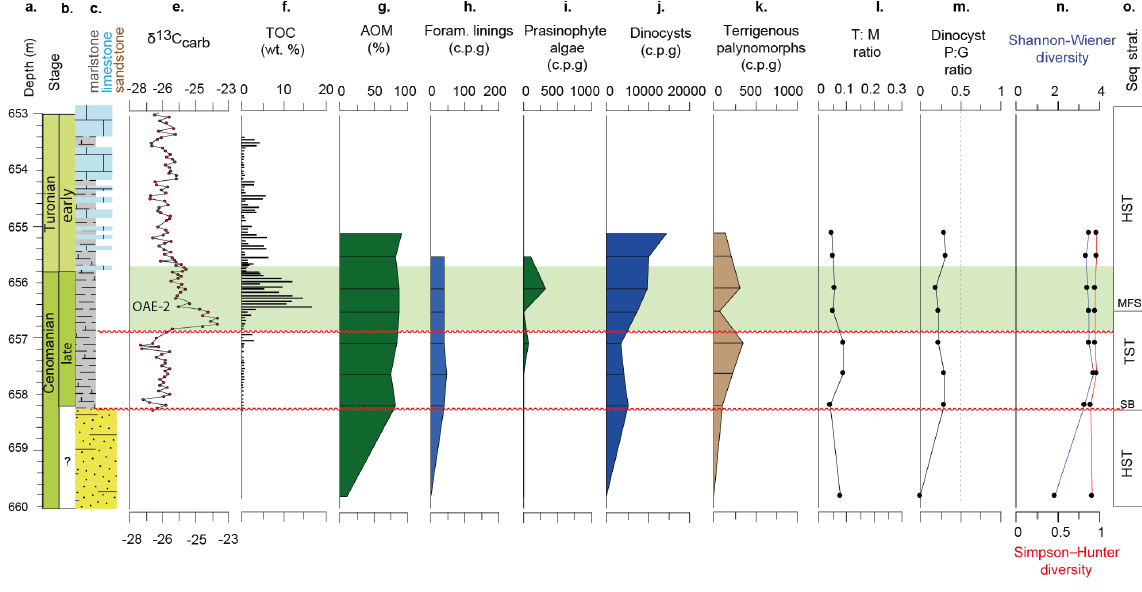
Figure 11. ODP Site 1138 data. Legend same as Fig. 4. δ 13 C org and TOC data from Dickson et al. (2016).